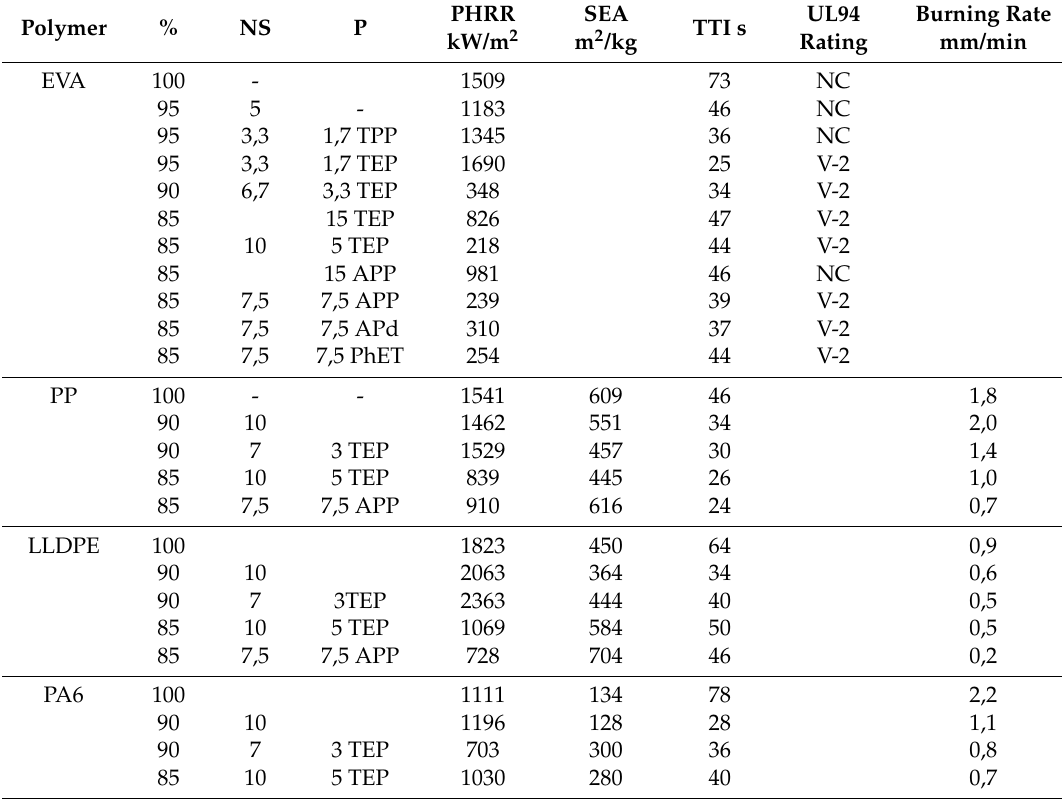
Table 4. Fire retardance performances of different polymers (data adapted from reference 61 and 62). Polymer